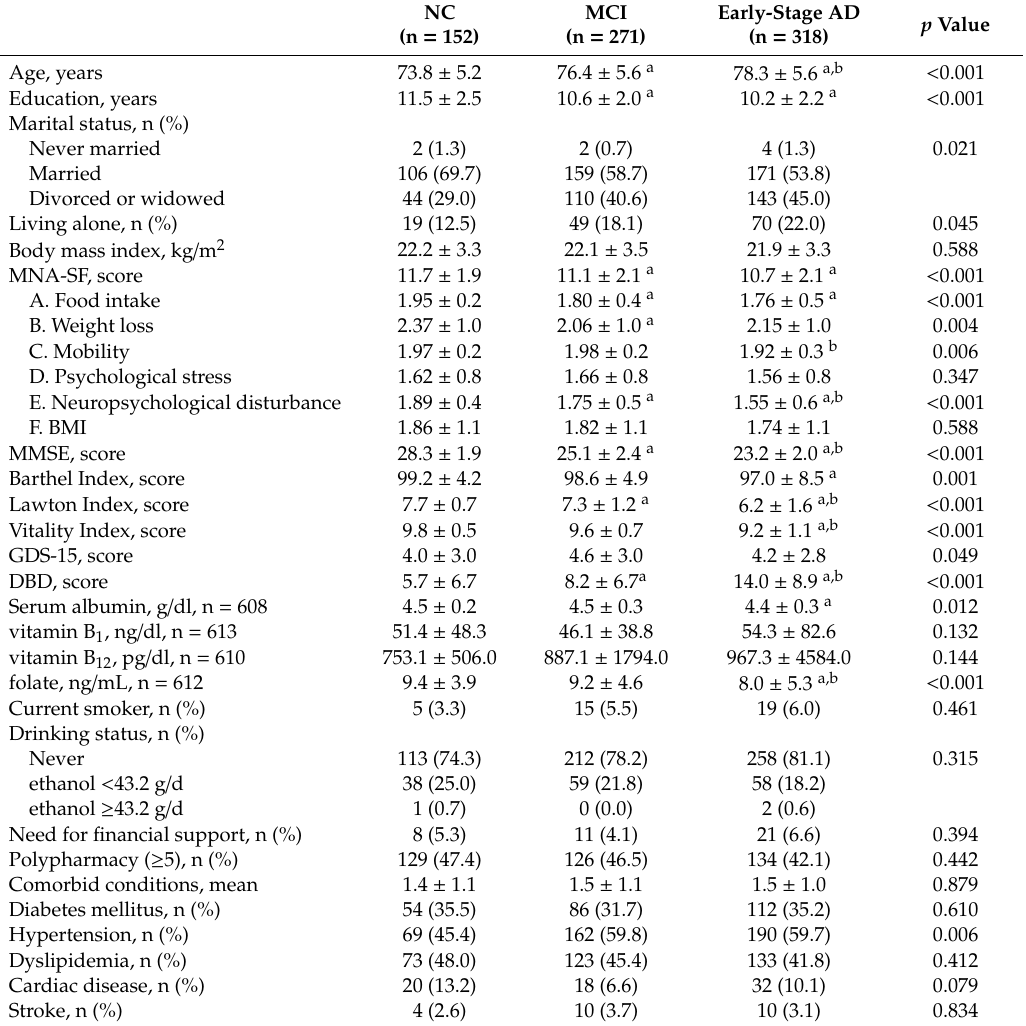
Table 2. Clinical characteristics of subjects at the respective cognitive stages 1